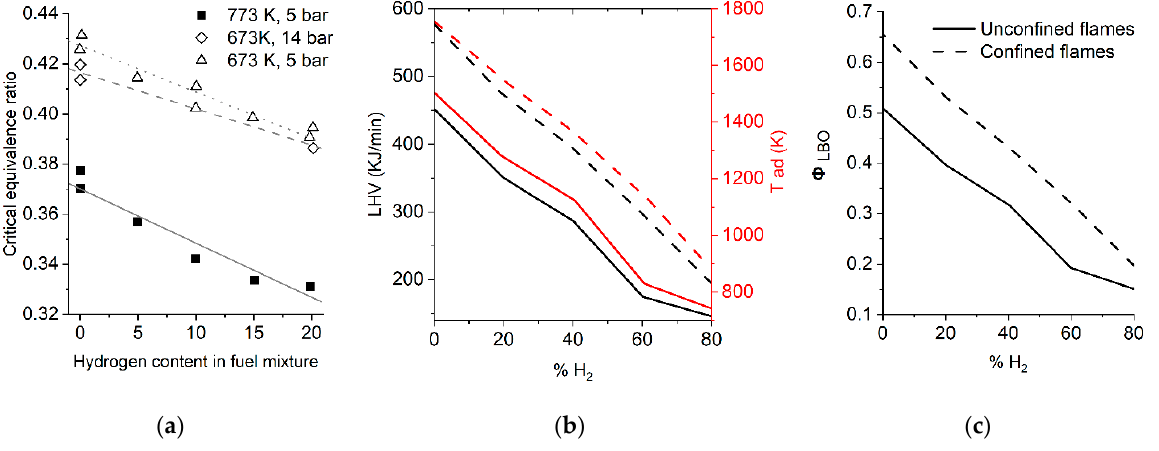
Figure 23. Influence of hydrogen volume fraction on lean flame blowout: ( a ) [52]; ( b ) [50]; ( c ) [50].